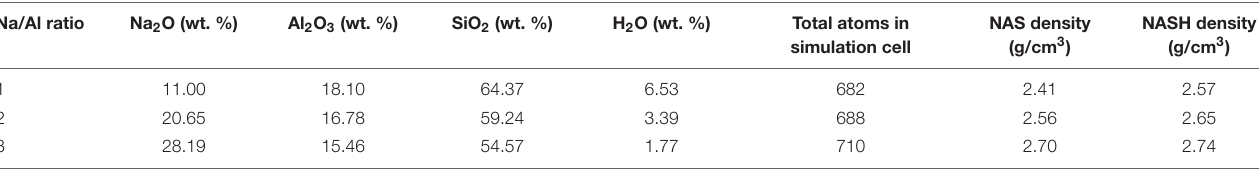
TABLE 1 | Compositions and densities of simulated NASH gel. Na/Al ratio Na 2 O (wt. %)